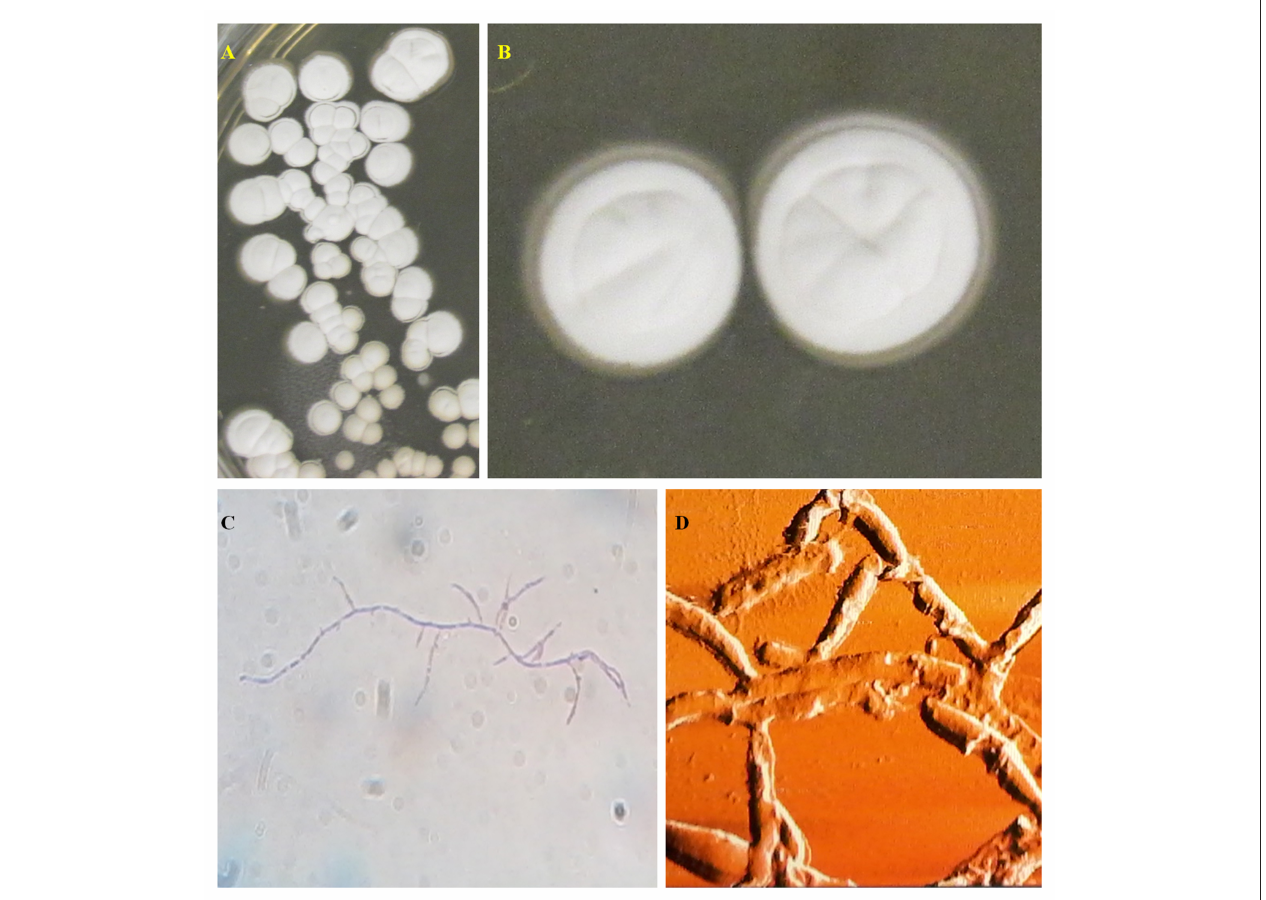
FIGURE 1 | Streptomycetes isolated from Brazilian medicinal plants (21) cultivated in IPS2 medium (agar 20.0 g/L, malt extract 10.0 g/L, dextrose 4.0 g/L, yeast extract 4.0 g/L, and distilled water) (A,B) and its microscopic characteristics in optical (C) and atomic force microscopy (D) . Source: Photos by Dr. F. P. N.